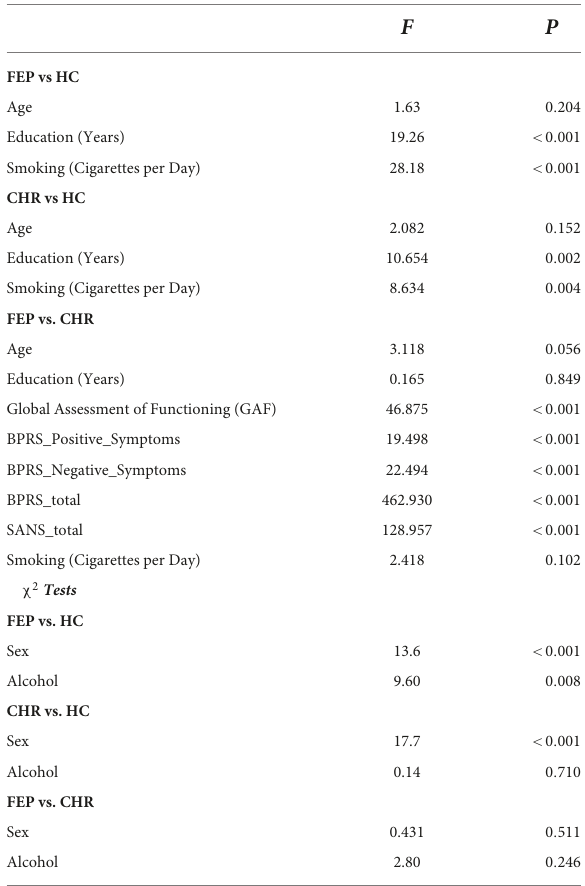
TABLE 1 Group comparison was investigated using 1-way ANOVA for continuous and χ 2 test for categorical